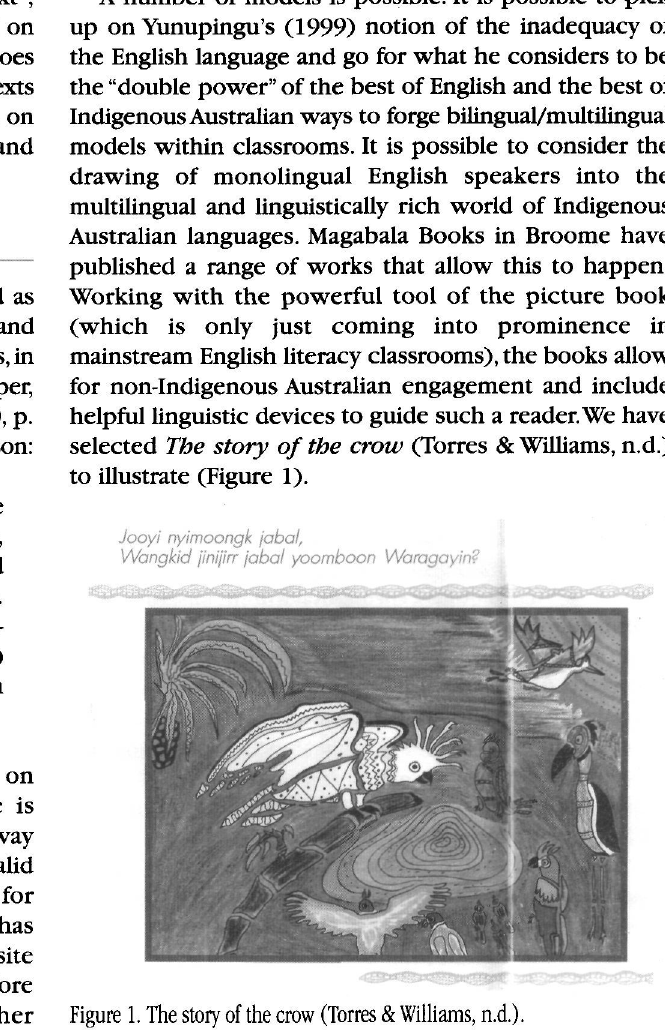
Figure 1. The story of the crow (Torres & Williams,